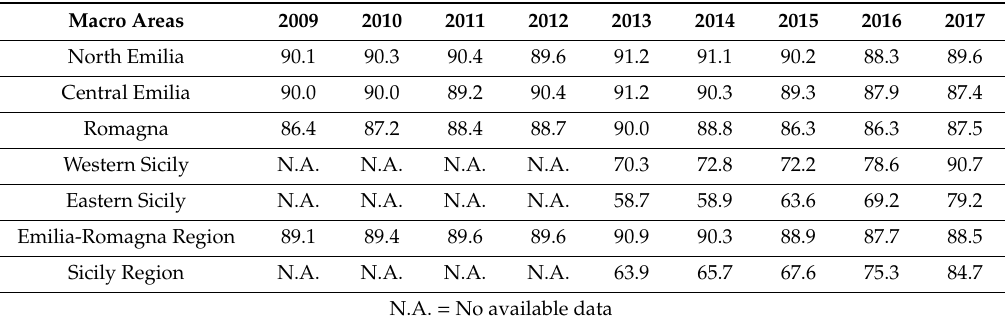
Table 2. MMR vaccine coverage rates at 7-years-old in Emilia-Romagna and Sicily for children with two doses (full vaccination